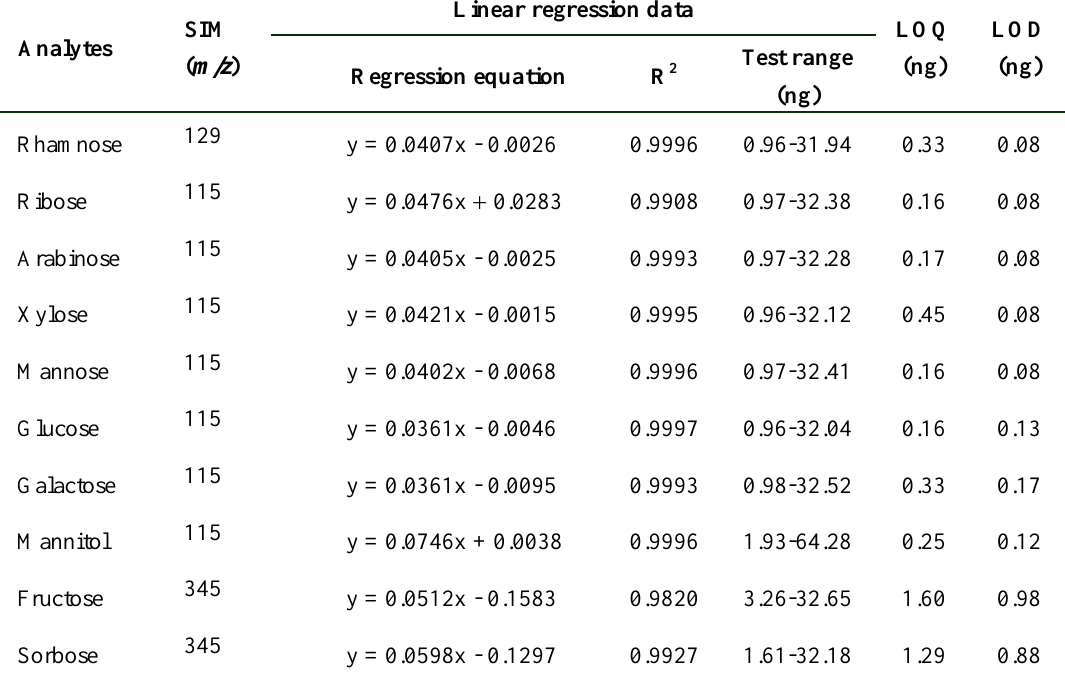
Table 1. Calibration data and LOQ, LOD for the derivatives of 10 monosacharides.